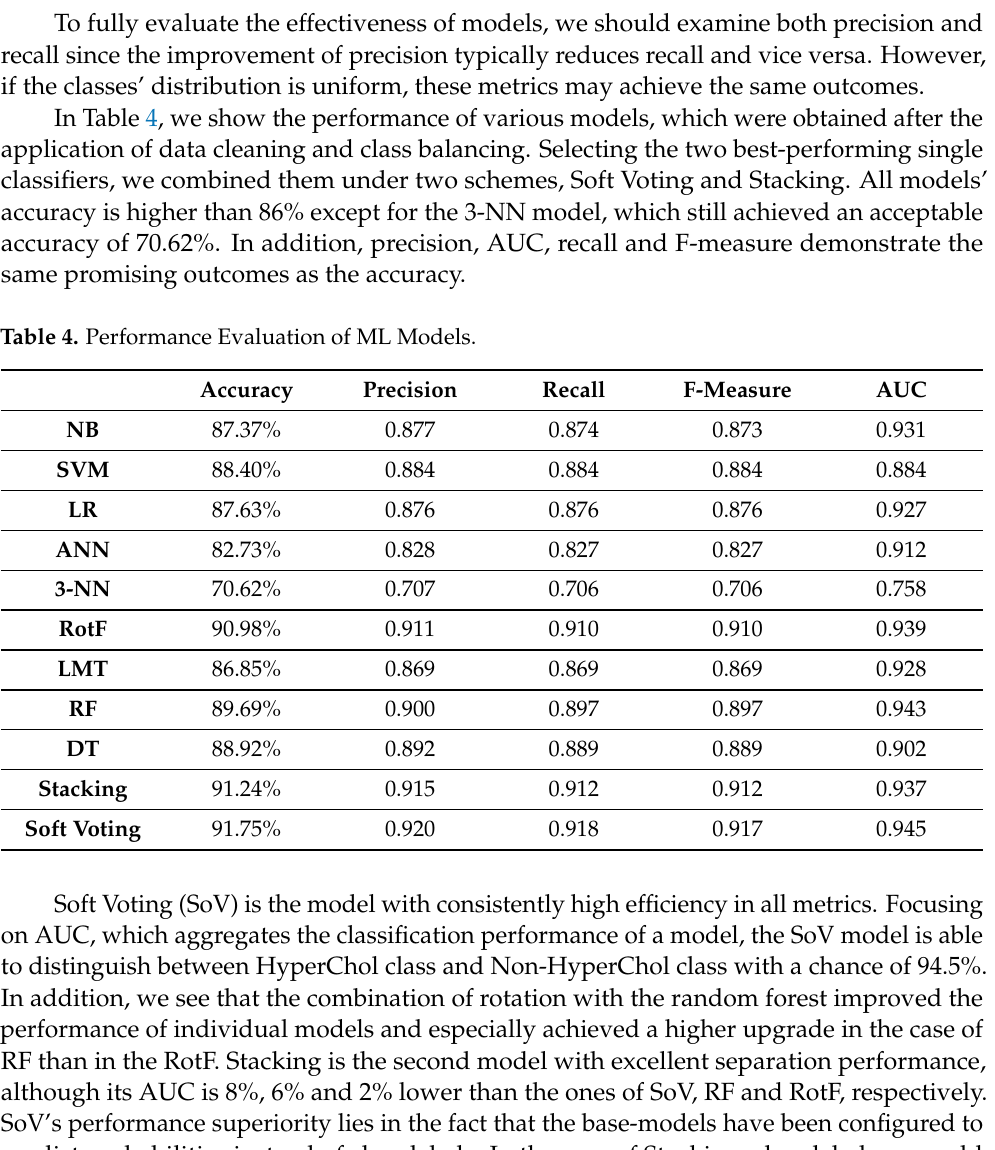
Search Algorithm: LinearNNSearch with Euclidean